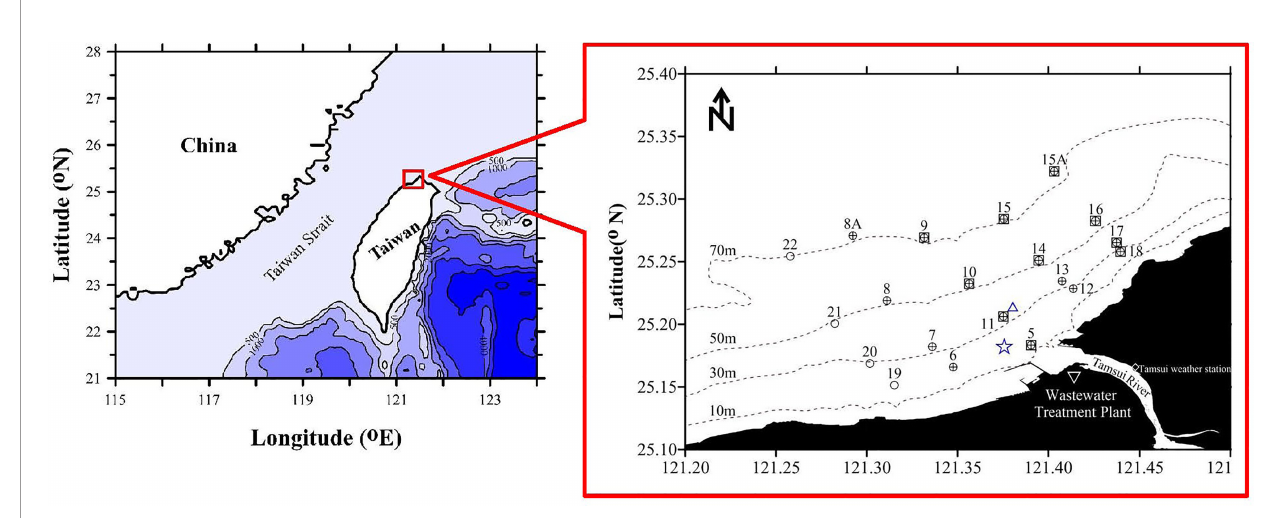
FIGURE 1 | Study area and station locations. +: OR2-2390 (November 2019); ○ : NOR2-0004 (May 2020) and NOR2-0009 (August 2020); □ : NOR2-0027 (January 2021). D : ocean outfall pipe of wastewater treatment plant. ☆ : Wind